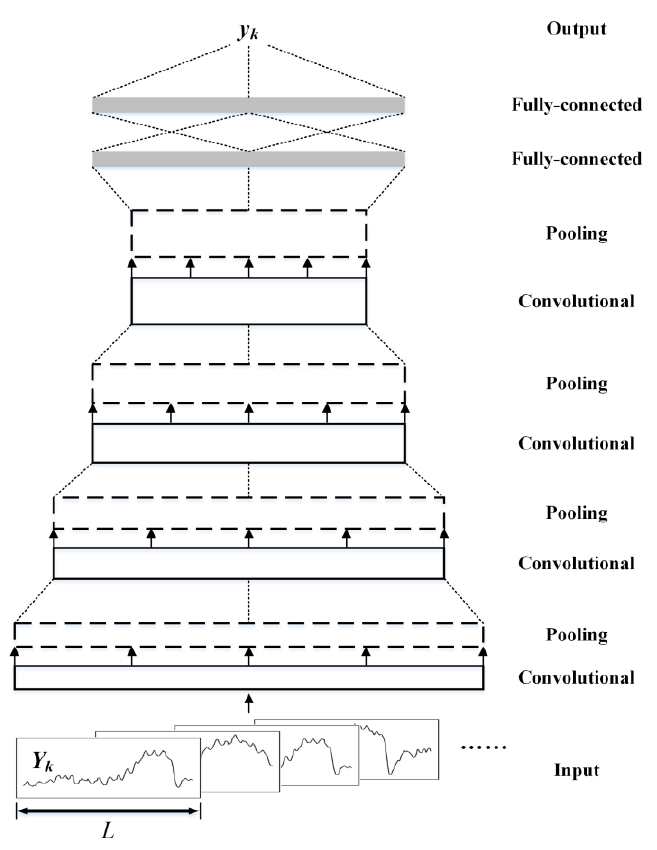
Figure 5. Structure of the proposed convolutional-neural-network.